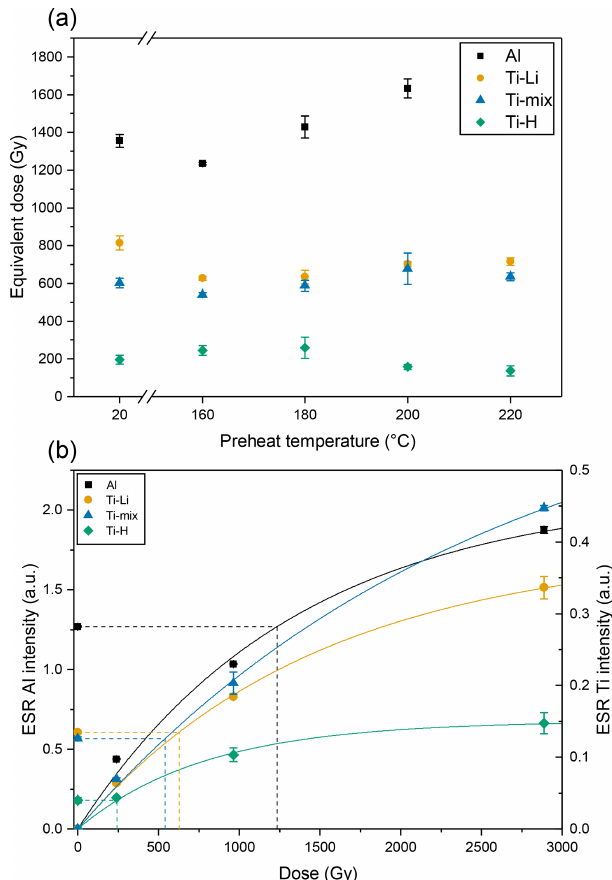
Figure 2. (a) Preheat plateau test for sample RB-II. The dose re- sponse curve for Al centre for 220 ◦ C did not fit, so the D e value was not obtained. (b) Dashed lines indicate the mean dose for each signal. (b) The DRCs for 160 ◦ C preheat temperature for each one of the ESR centres. The D e values are marked.